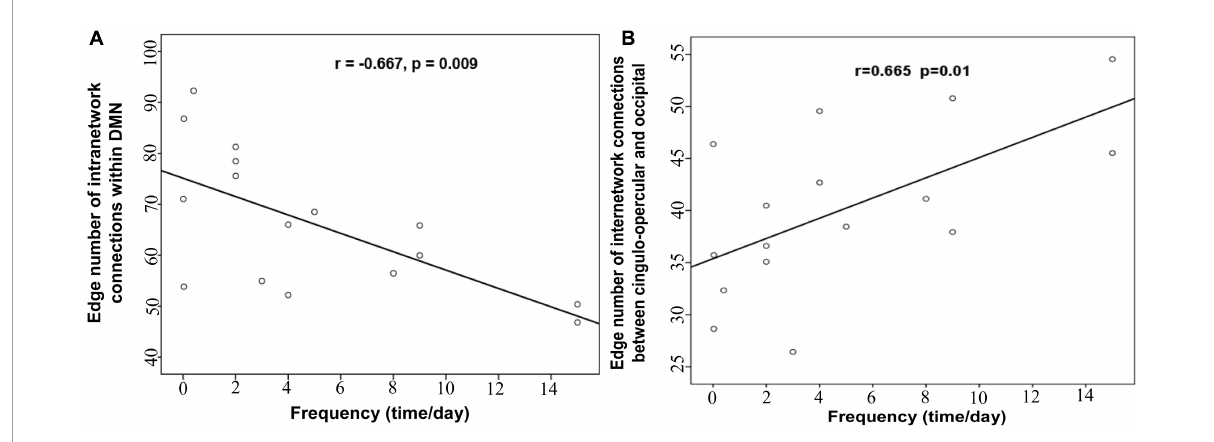
FIGURE4 The correlation (A) between the intra-modular connections within DMN and the epilepsy frequency, (B) between the inter-modular connections and the epilepsy